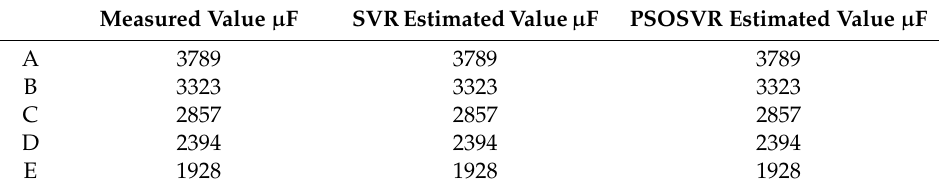
Table 1. Training data and estimation